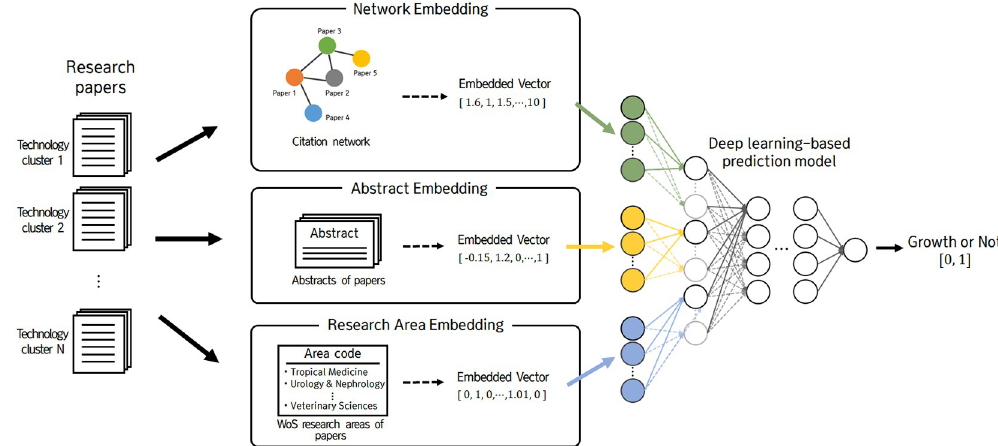
Fig 1. Overview of deep learning model for prediction of future growth